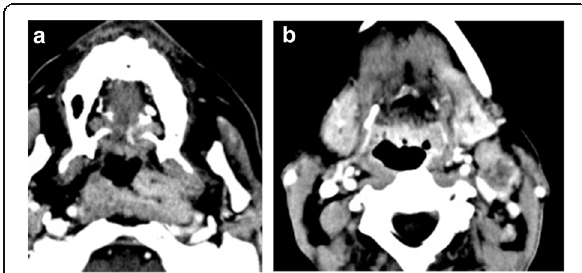
Fig. 6 A 25 years old female with asymmetric thickening of nasopharyngeal recess in a proven NPC ( a ) and necrotic SSC node at nodal level II on the left side ( b